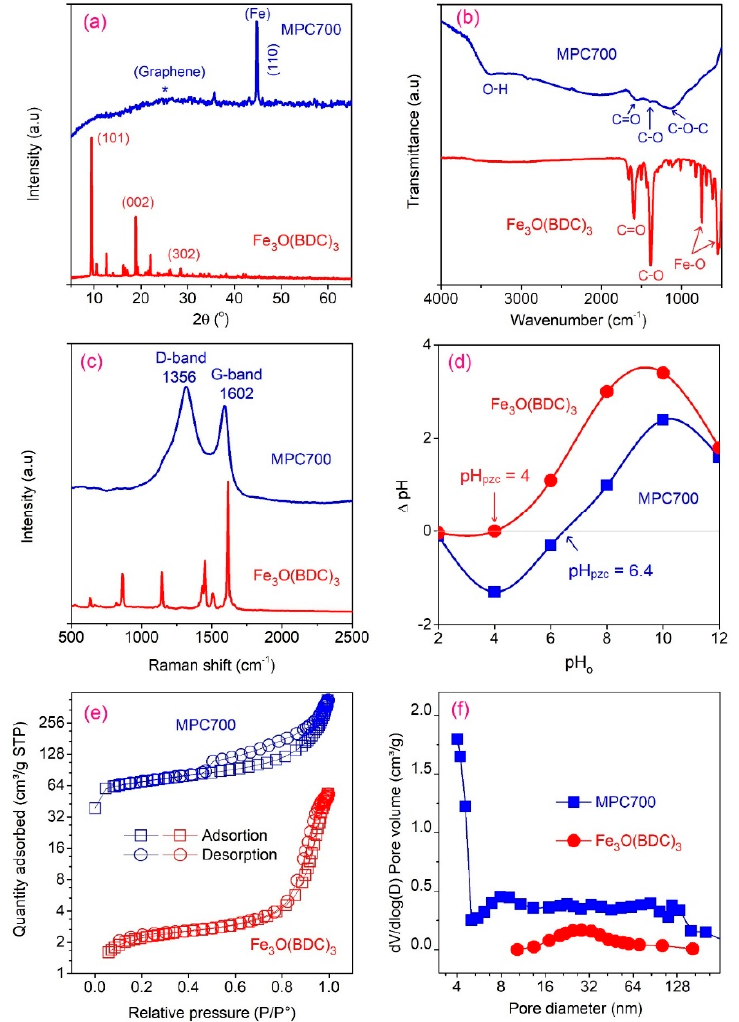
Figure 2. The XRD ( a ), FTIR ( b ), Raman ( c ), pH pzc ( d ), nitrogen adsorption/desorption ( e ), and pore size distribution ( f ) of Fe 3 O(BDC) 3 and MPC700.